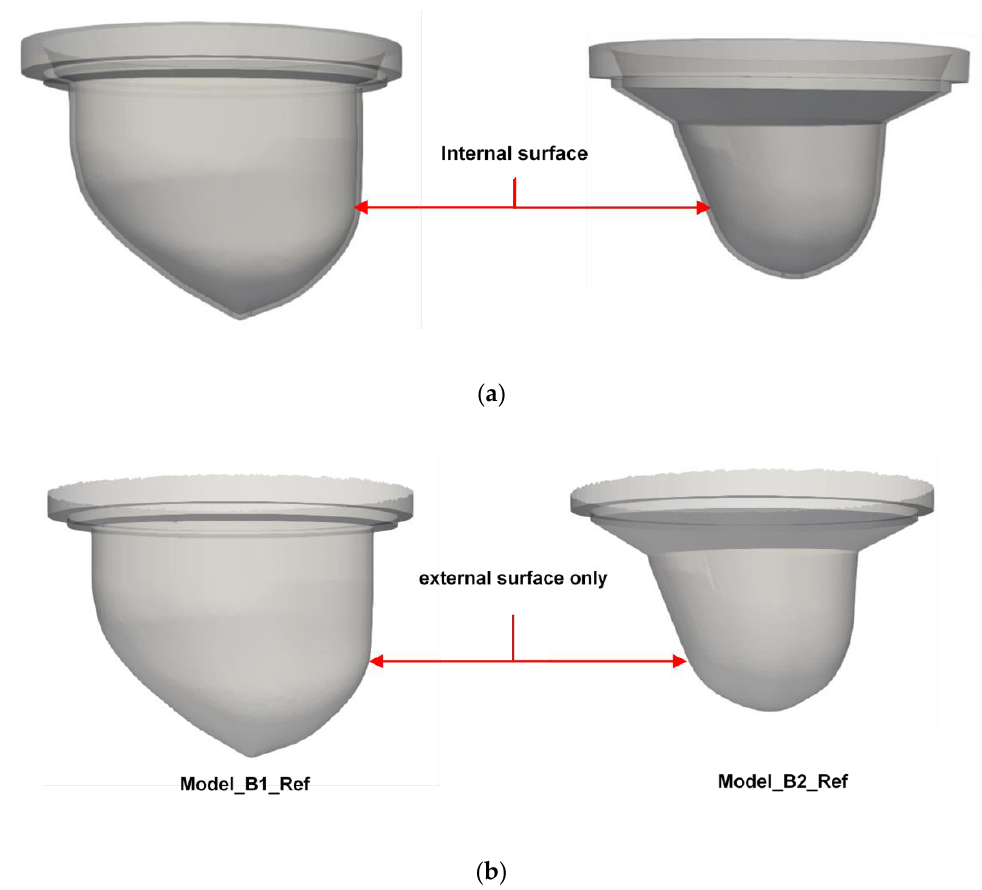
Figure 28. 3D breast phantom representations ( a ) before, ( b ) after application of the surface pre-processing step.